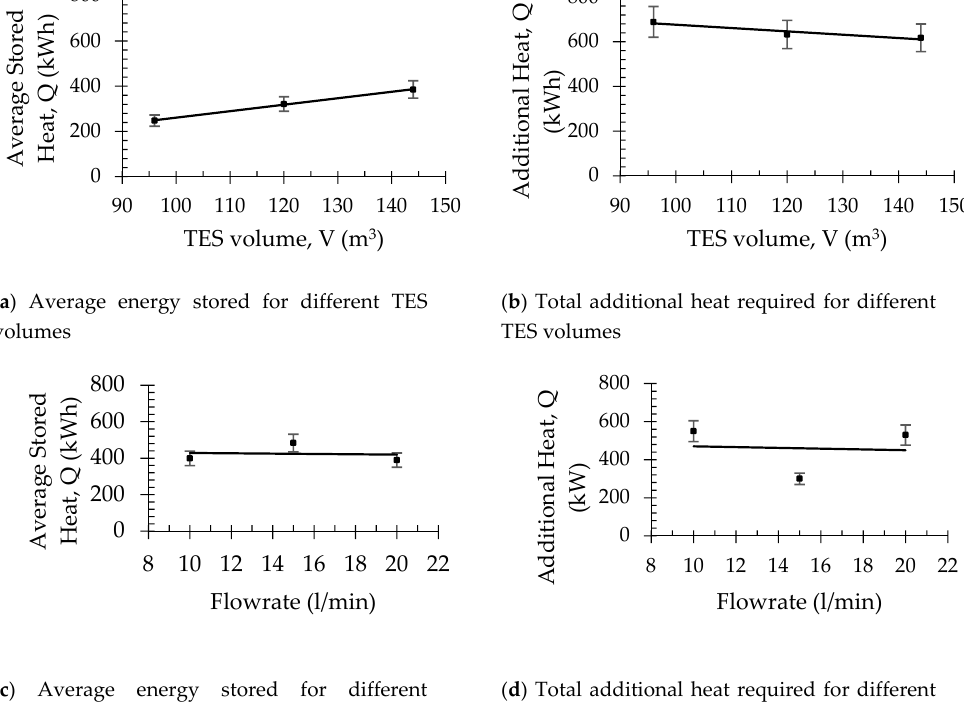
Figure 11. ‘Sensitivity’ analysis ( a , b ) on the foundation volume (for thicknesses between 0.8 m (volume = 96 m 2 ) and 1.2 m (volume = 144 m 2 ), and ( c , d ) on flowrate (for flowrates between 10 and 20 L per minute) (percentage error bars shown, based on